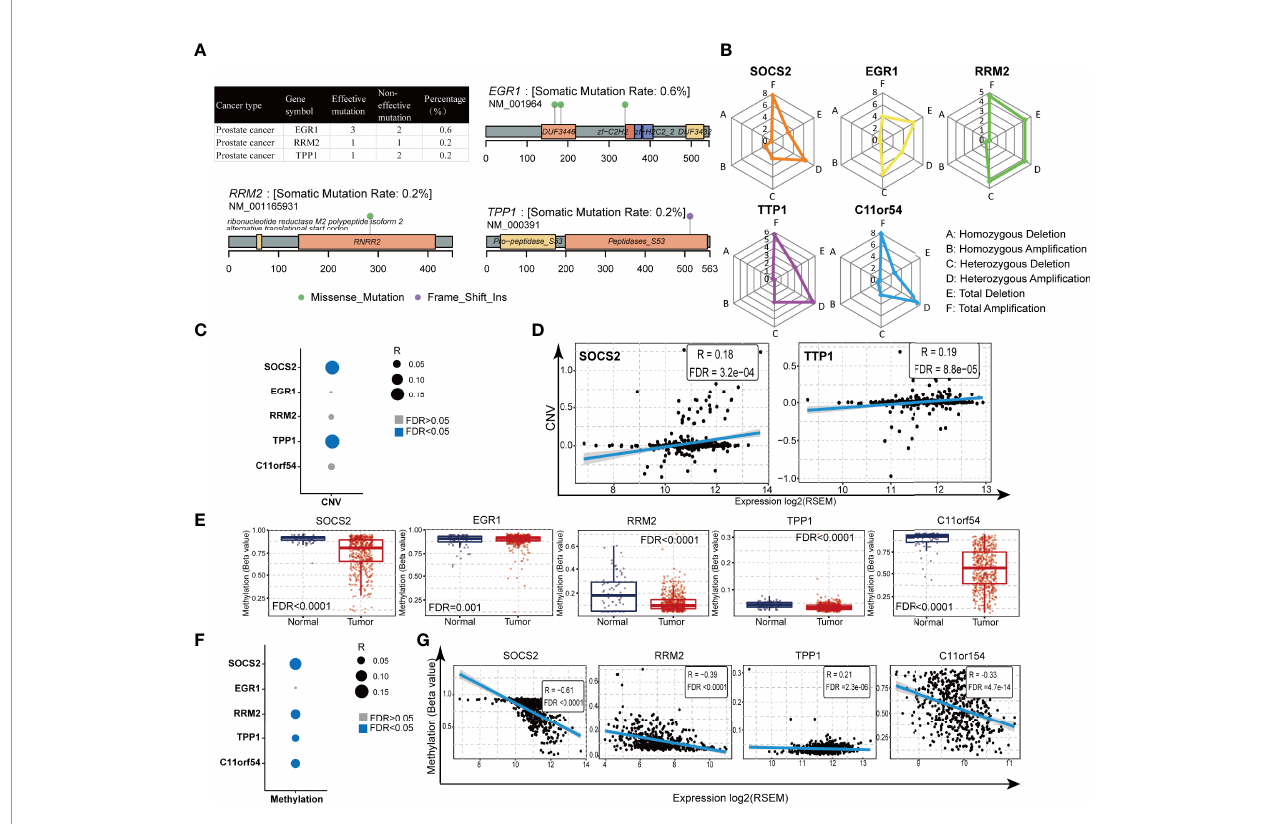
FIGURE 4 | Gene alteration and methylation landscape of the fi ve genes in the TILTregSig in prostate cancer. (A, B) The SNV status of the fi ve genes in the TILTregSig of prostate cancer patients in GSCALite. (C) The correlation between CNV and the expression levels of the fi ve genes in the TILTregSig of prostate cancer patients in GSCALite. (D) The correlation between CNV and the expression levels of SOCS2 and TPP1. R : Spearman ’ s correlation coef fi cient. FDR, false discovery rate. (E) The difference of gene methylation between normal and prostate cancer samples. (F) The correlation between gene methylation and the expression levels of the fi ve genes in the TILTregSig of prostate cancer patients in GSCALite. (G) The correlation between gene methylation and the expression levels of SOCS2, RRM2, TPP1, and C11orf54. R : Spearman ’ s correlation coef fi cient. FDR, false discovery